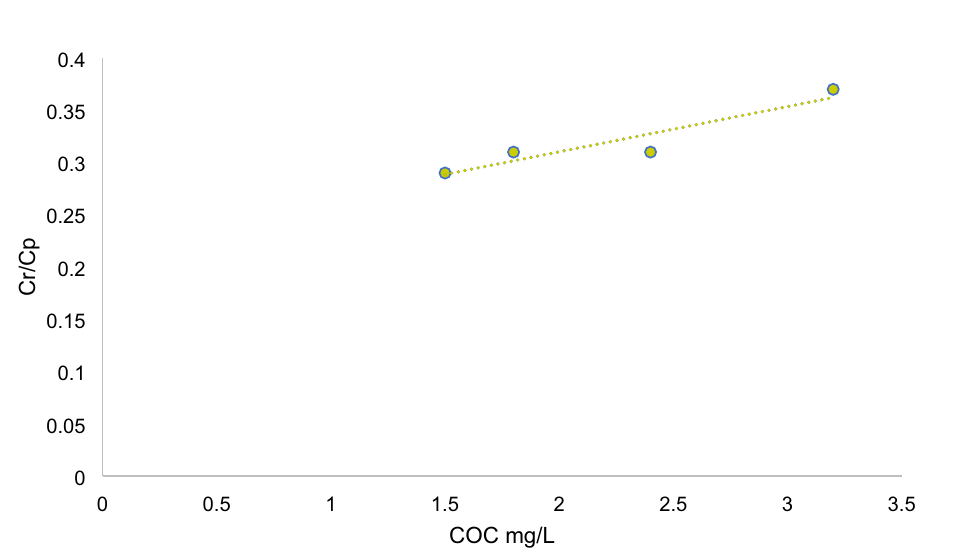
Figure 10. Ratio of BPA concentration in retentate (C r ) to permeate (C p ) in relation to colloidal organic carbon